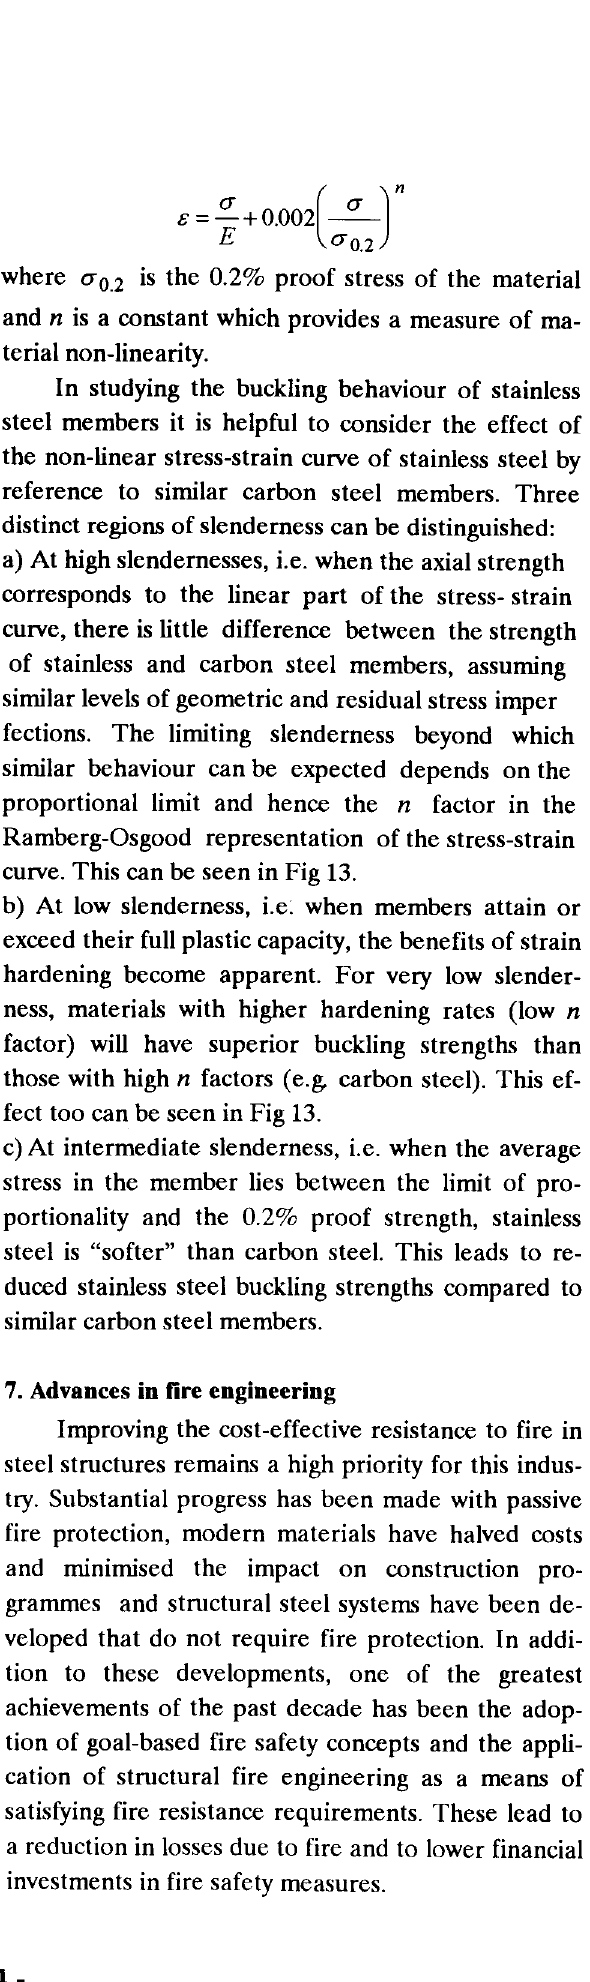
Fig 13. Effect of material non-linearity on buckling